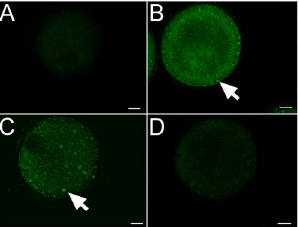
Figure 5. Effect of MG and resveratrol treatment on distribu- tion of mitochondria in meiosis. ( A ) and ( D ) Representative mitochondrial distribution patterns detected by fluorescence micros- copy using MitoTracker Red at GV and MII stage in control group. ( B ) and ( E ) Representative mitochondrial distribution patterns at GV and MII stage in MG-treated group. ( C ) and ( F ) Representative mitochondrial distribution patterns at GV and MII stage in RSVL-MG-treated group. Scale bar =20 m m.